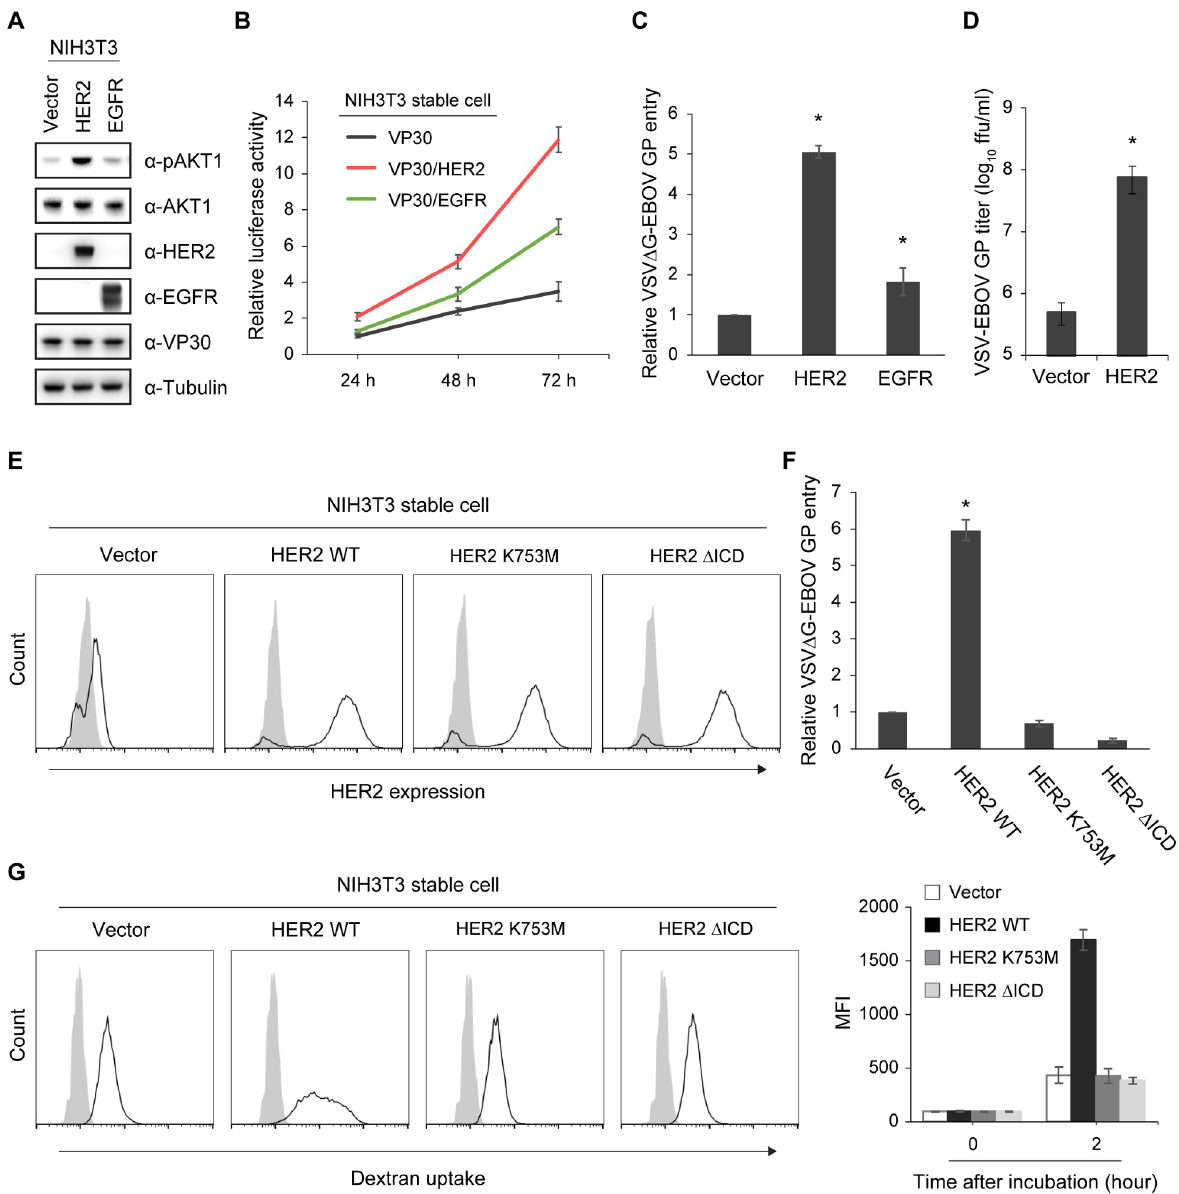
Fig 4. HER2 kinase-mediated enhancement of EBOV entry and macropinocytosis. (A) Phosphorylation of AKT1 in NIH3T3 VP30 cells stably expressing HER2 or EGFR. The indicated protein expression levels were analyzed by immunoblotting. (B) EBOV-driven luciferase activity in NIH3T3 VP30, NIH3T3 VP30/HER2, or NIH3T3 VP30/EGFR cell lines infected with EBOV Δ VP30-luc. Virus-driven Renilla luciferase activity was measured at 24, 48, and 72 h post-infection. The relative changes compared to the luciferase activity from the NIH3T3 VP30 cell line at 24 h post- infection are presented as means ± SD. Data are representative of experiments performed in triplicate and repeated twice. (C) Relative luciferase activity in NIH3T3 stable cell lines expressing HER2 or EGFR, or in an empty vector control cell line, after infection with VSV Δ G-EBOV GP virus at an MOI of 0.5. Data are presented as means ± SD, and are representative of experiments performed in triplicate and repeated at least three times. ( � ) indicates a statistically significant difference ( p value � 0.05) from the control. (D) Titers of VSV-EBOV GP from the NIH3T3 HER2 cell line or its empty vector control cell line infected with VSV-EBOV GP at an MOI of 0.001. Virus titers were determined on day 2 post-infection. Data are presented as means ± SD, and are representative of three independent experiments. ( � ) indicates a statistically significant difference ( p value � 0.05) from the control. (E) HER2 cell surface expression in NIH3T3 stable cell lines expressing either HER2 WT or the indicated kinase-deficient mutants or in an empty vector control cell line. Cells were stained with anti-HER2 antibody (black line) or a control antibody (gray shading) and analyzed by flow cytometry. (F) Relative luciferase activity in the NIH3T3 stable cell lines shown in (E) after infection with VSV Δ G-EBOV GP virus at an MOI of 0.5. Data are presented as means ± SD, and are representative of experiments performed in triplicate and repeated at least three times. ( � ) indicates a statistically significant difference ( p value � 0.05) from the control. (G) Dextran uptake by the NIH3T3 stable cell lines shown in (E) after incubation with 400 μ g/ml dextran 10K-Alexa 594 for 0 h (gray shading) or 2 h (black line). Cells were analyzed by flow cytometry. The graph on the right represents the MFI ± SD from experiments performed in triplicate and repeated twice.